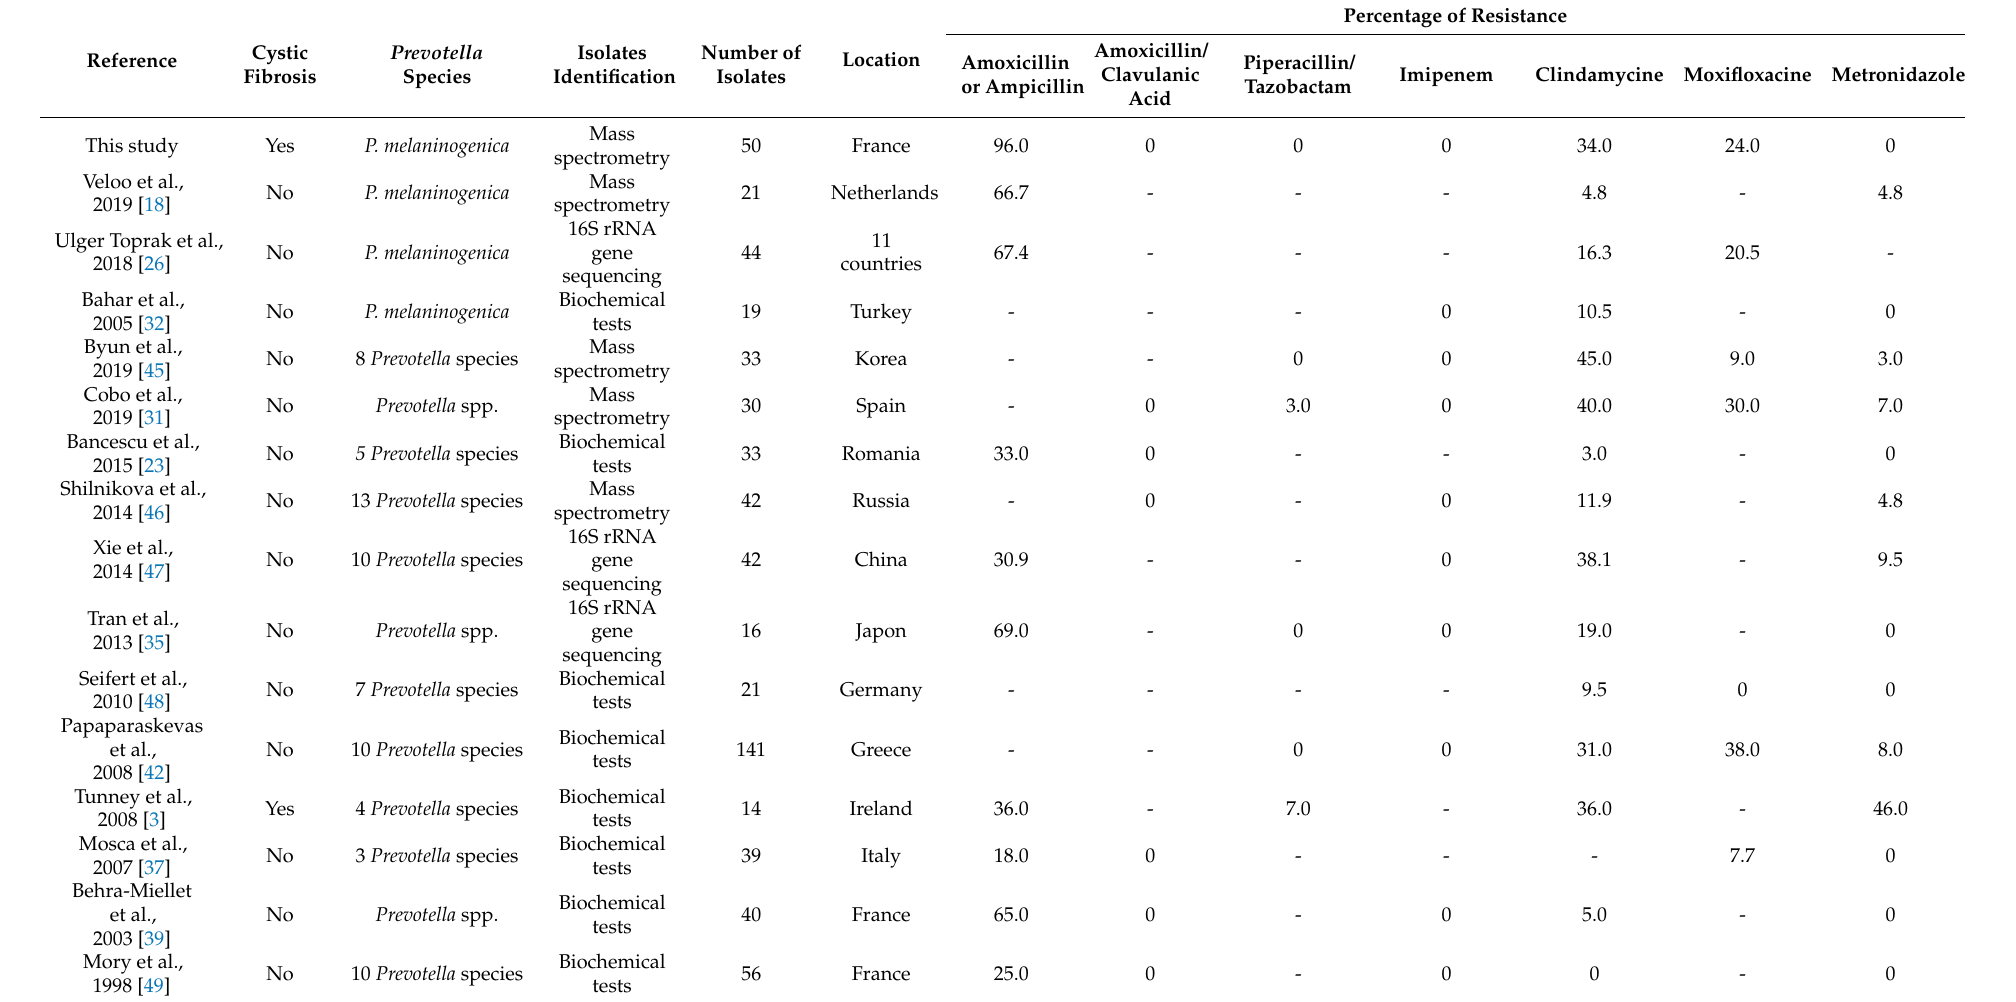
Table 4. Studies reporting antibiotic resistance of Prevotella